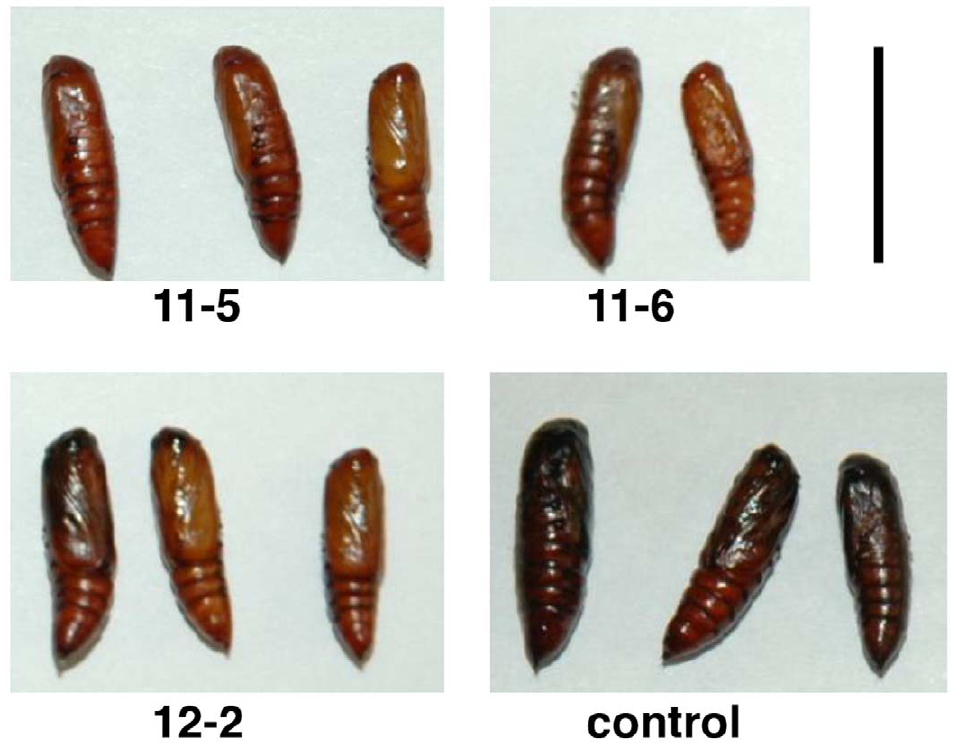
Figure 4. Fall armyworm pupae from feeding bioassays on N.benthamiana plants transformed with the BvSTI gene. Transformant 11-5, 11-6 and 12-2 and untransformed normal control plant. Bar corresponds to 1 cm.